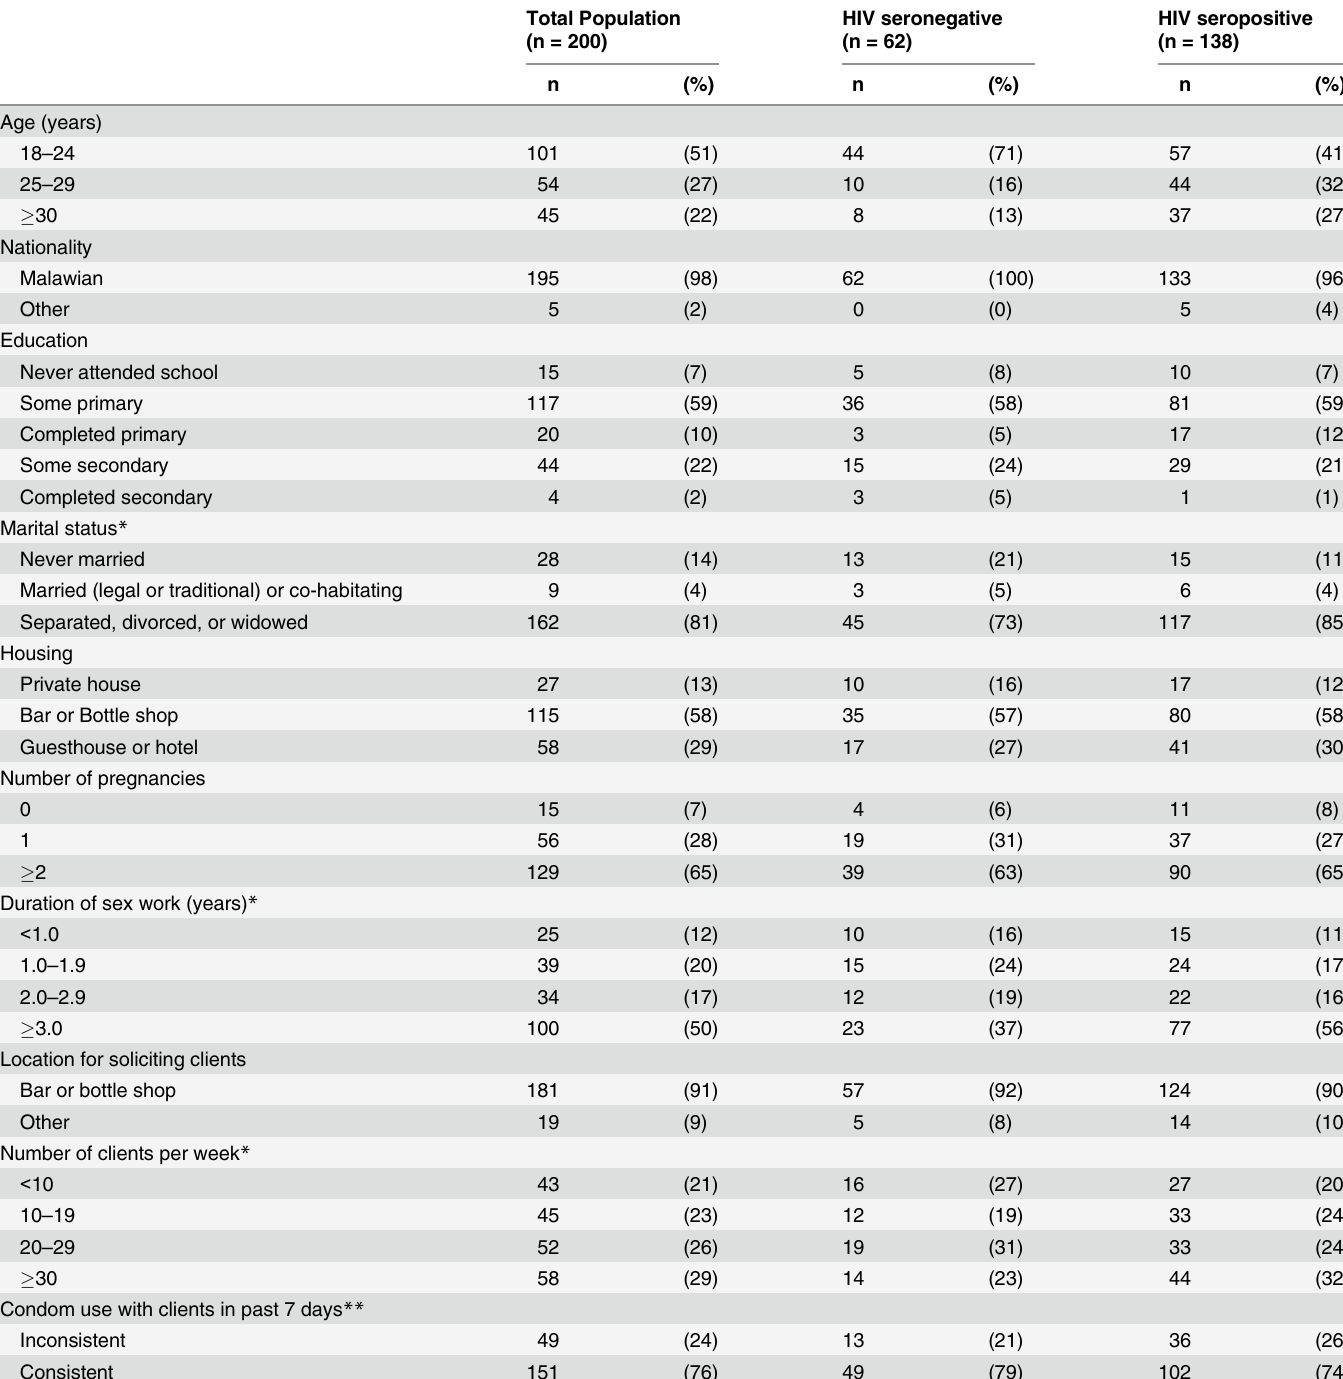
Table 1. Sociodemographics and sex work characteristics of female sex workers in Lilongwe, Malawi, July-September